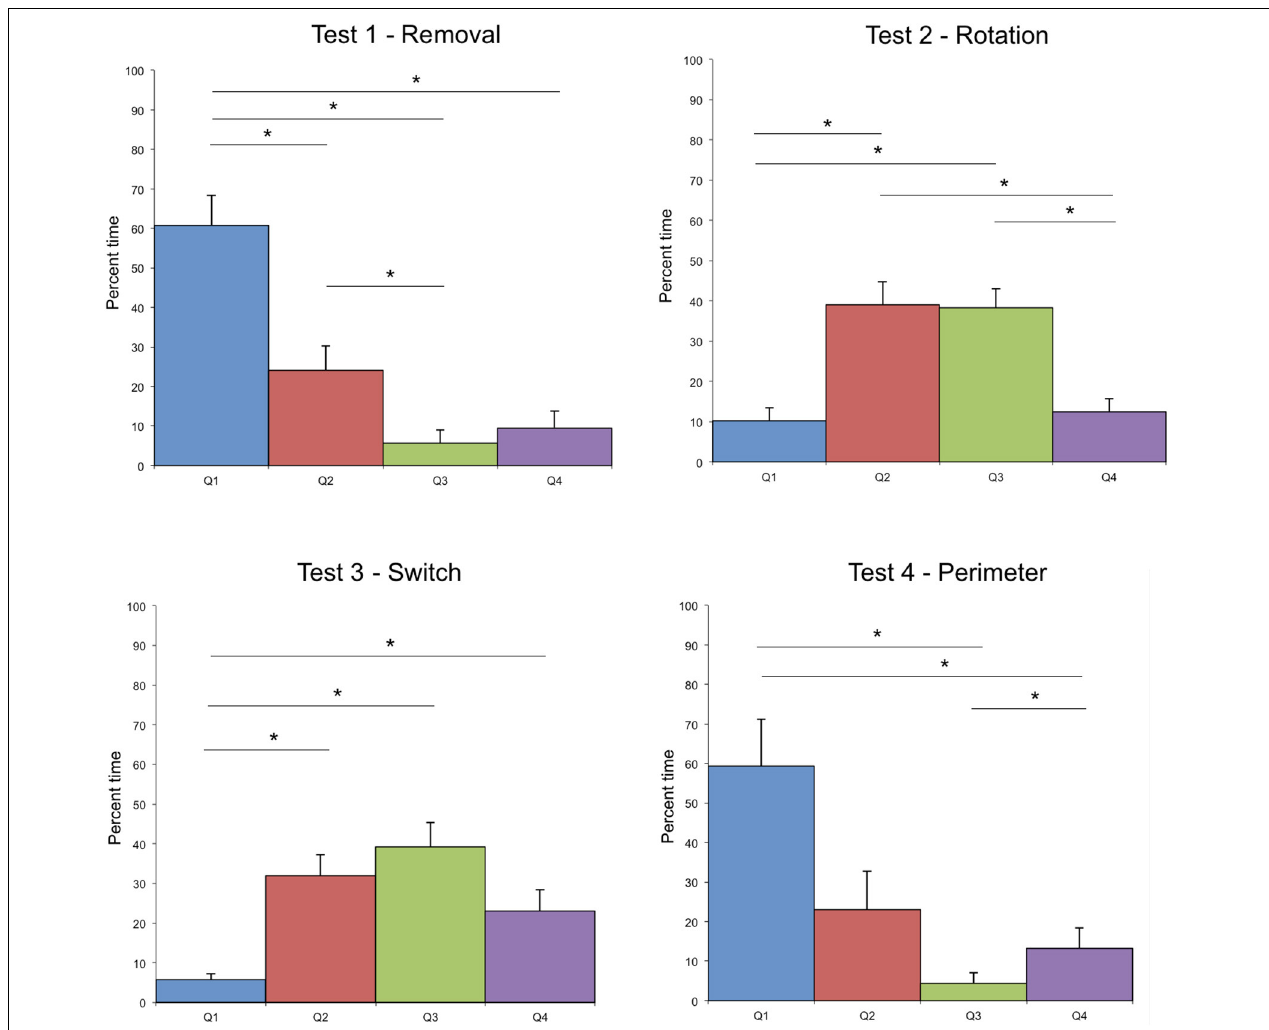
FIGURE 3 | Distribution of mean time spent in each quadrant of the exploration area in the four different tests. Error bars represent the standard error of means, ∗ indicates significant differences. Test 2—Rotation, Wilcoxon signed rank test indicates differences between Q1 and Q2, z = 2 . 4,